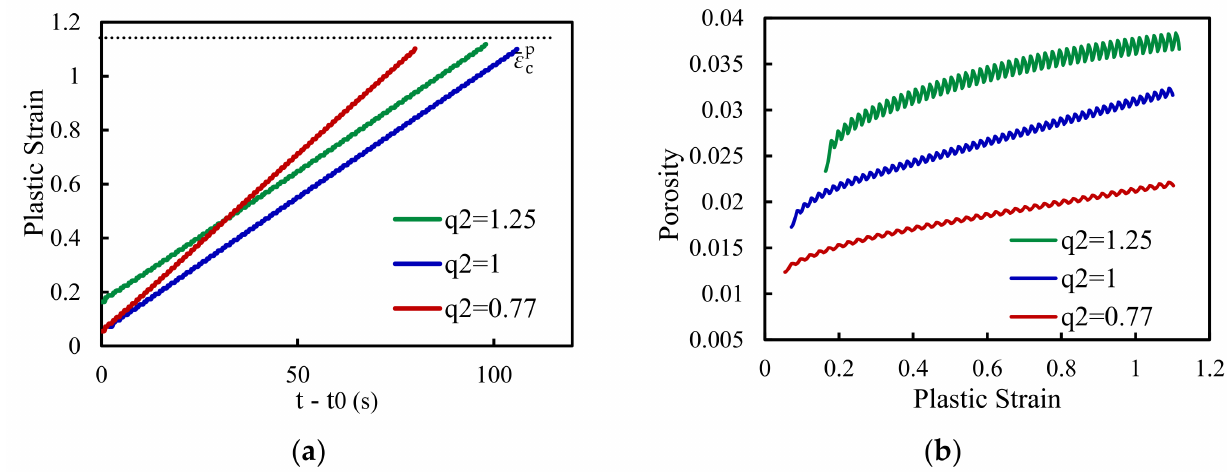
Figure 10. ( a ) Plastic strain evolution in terms of the distinct values of q 2 . ( b ) Porosity evolution, due to the increase in plastic strain, for the same values of q 2 previously referred. Results are shown in natural